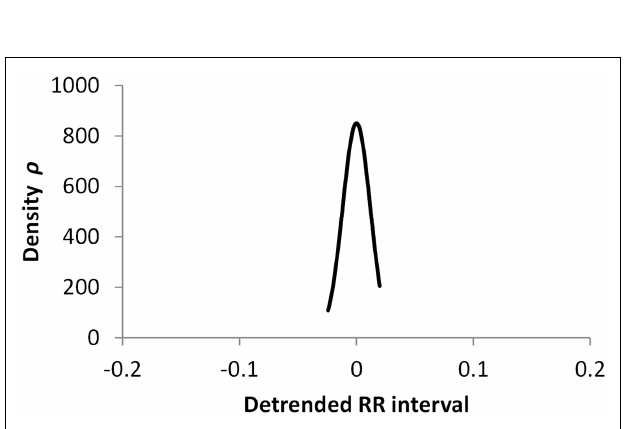
FIGURE 6 | Density of detrended RR intervals plotted against the RR interval value for participants in the Early CAN group .The SD is 0.023.